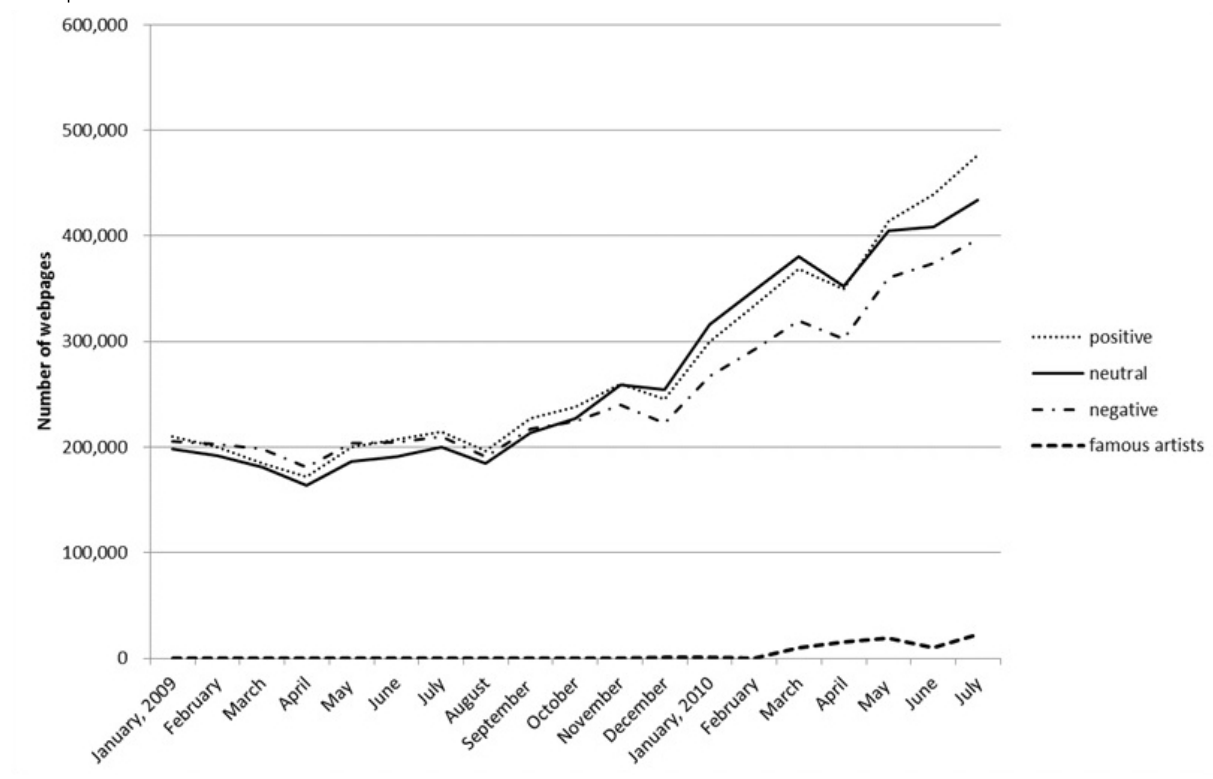
Figure 5. Serial changes in the number of Web pages containing positive, negative, and neutral keywords related to cervical cancer and the names of relevant Japanese